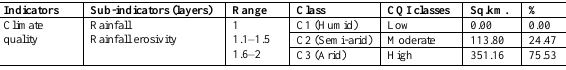
Table 7. Quantitative scores and qualitative classes of climate indicators.